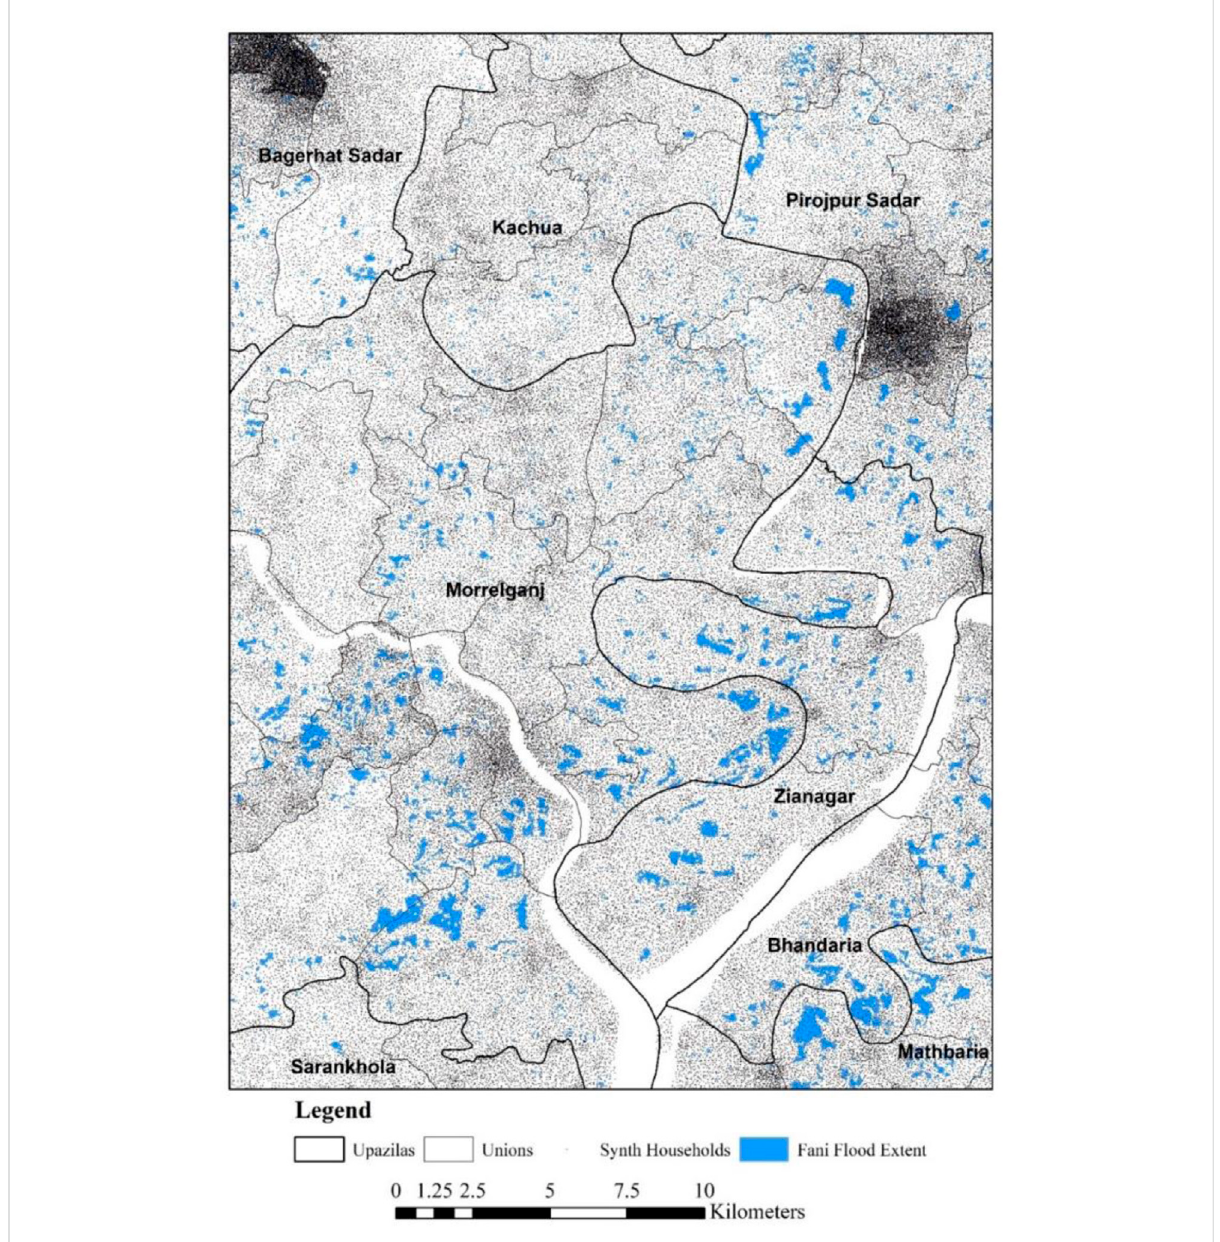
FIGURE 3 Synthetic households (dark points) and Cyclone Fani fl ood extent (in blue) spanning sections of Bagerhat and Pirojpur